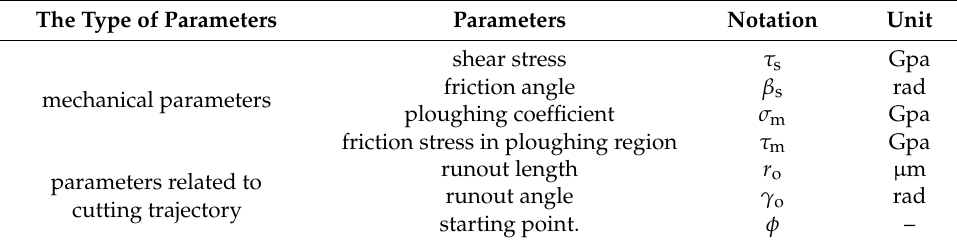
Table 1. Parameters to be